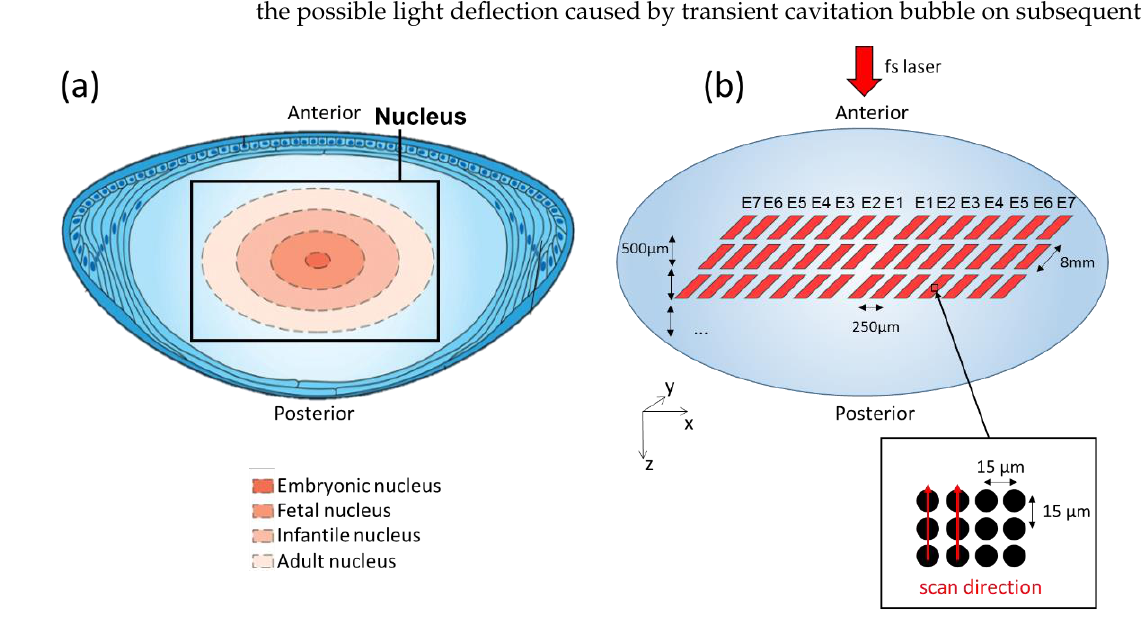
Figure 1. Femtosecond laser pattern on the crystalline lens nucleus. ( a ) Diagram of porcine crystalline lens anatomy (adapted from Ento Key, basic science of lens, https://entokey.com/basic-science-of-the-lens/, accessed on 3 October 2019) showing, on a cross section, the 4 layers from the adult to the embryonic nucleus; ( b ) 3D schematic of the single-pulse laser patterns with various energies and depths for the investigation of laser–lens interaction within the nucleus volume.